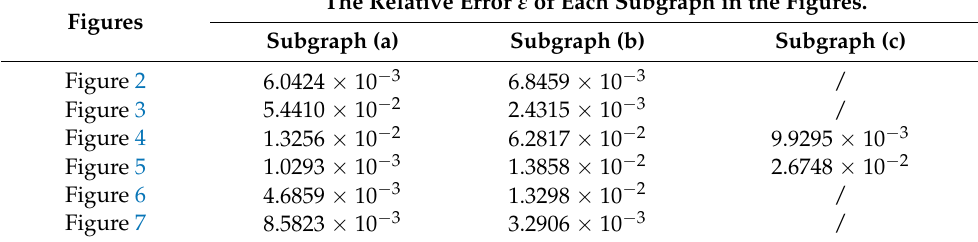
Table 1. The errors of degree reduction for the examples in Figures